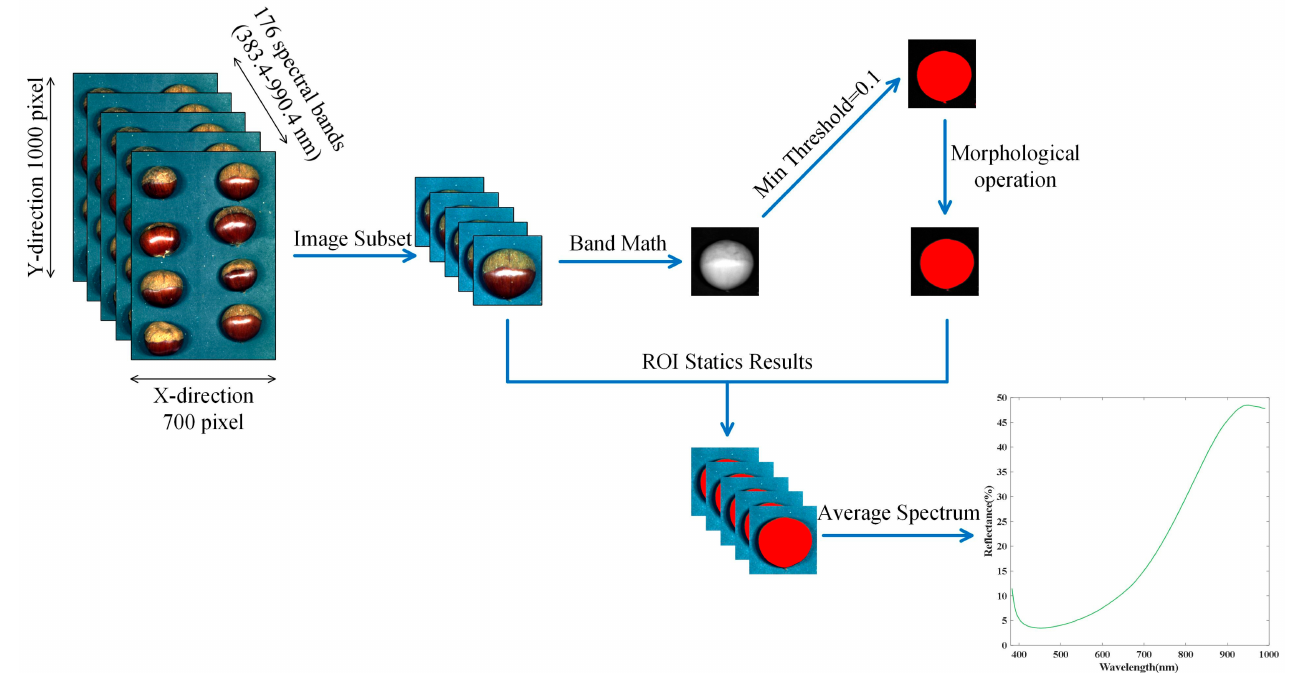
Figure 1. The extraction process of